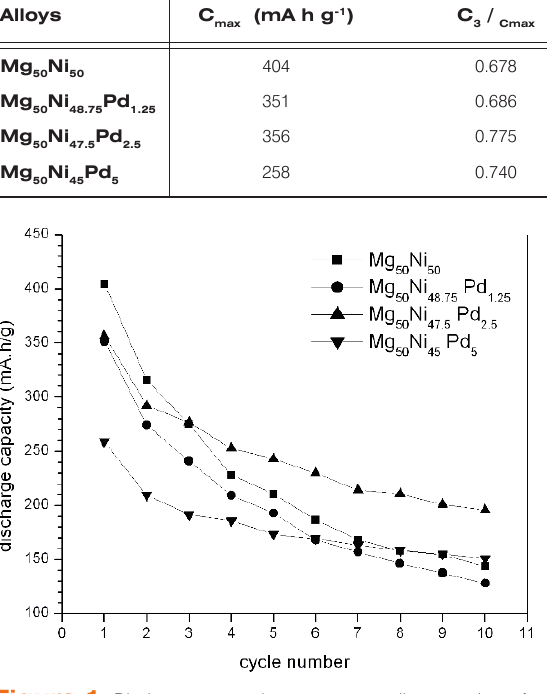
Mg Ni Pd alloy electrodes. 50 (50-x) x